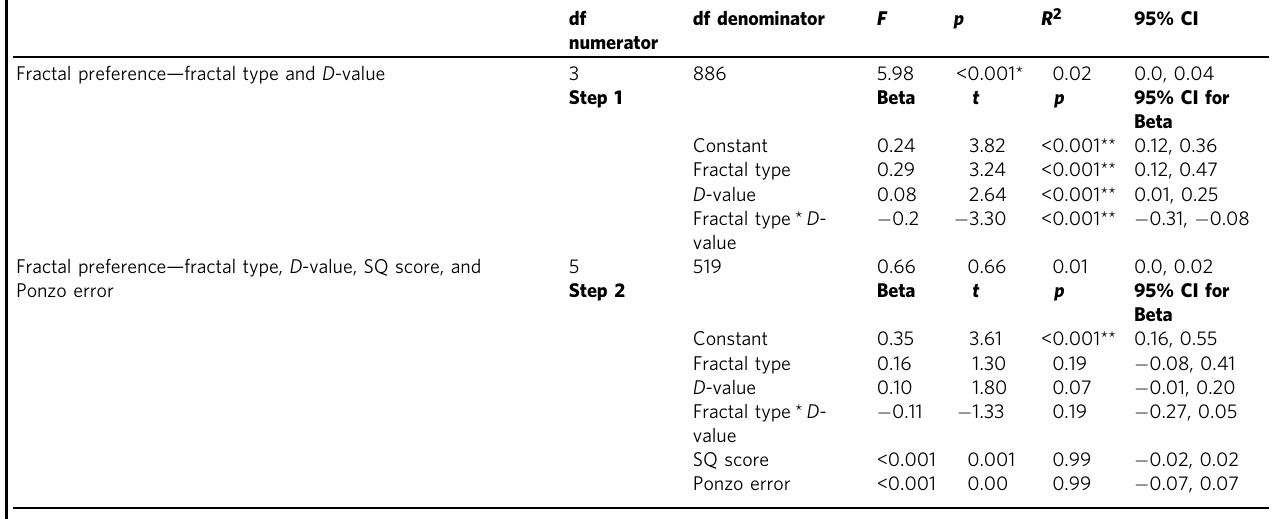
Table 5 Two-step regression predicting fractal preference.